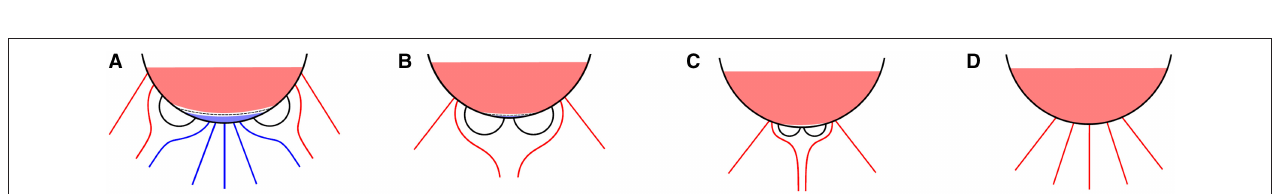
FIGURE 1 | Evolution of the pseudostreamer observed with SWAP 174 Å waveband. Color scale is inverted, so black corresponds to the higher intensity values.